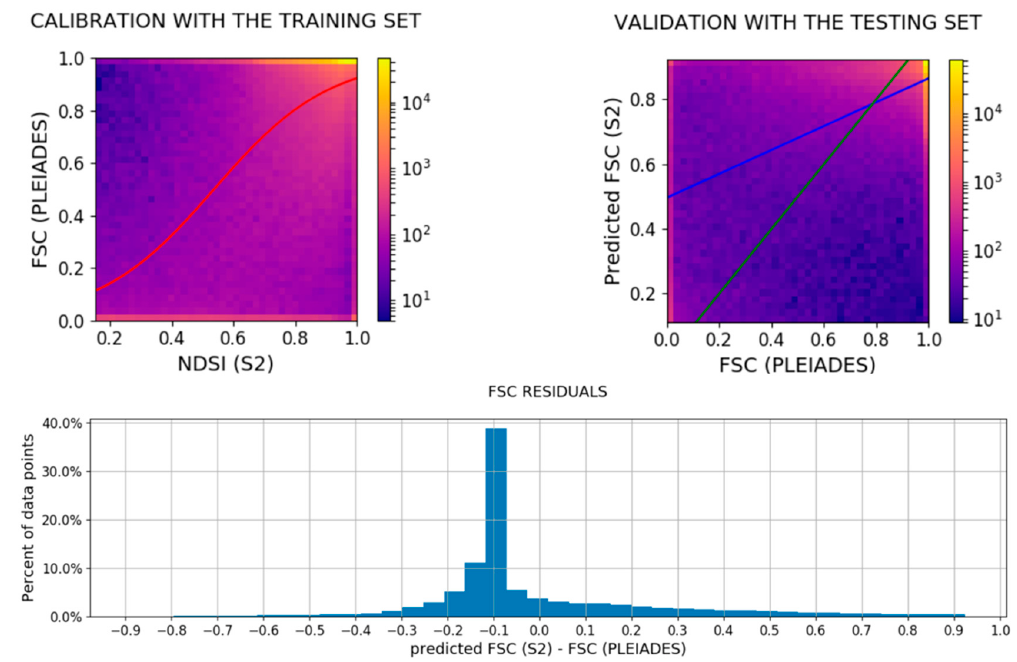
Figure 7. Results of the calibration and validation of the function. Upper left panel: 2D histogram plot of the FSC and NDSI pairs in the training dataset and optimized function. Upper right panel: 2D histogram plot of the predicted FSC vs. the testing FSC dataset. Red line: calibrated NDSI–FSC function. Blue line: Linear regression between the predicted and the testing FSC sets. Green line: 1:1 line. The color bar indicates the number of samples by bin. Bottom: histogram of the residuals for the validation (predicted FSC minus FSC test). Table 3. Validation of the predicted FSC against the testing dataset (Pléiades data). Metric.